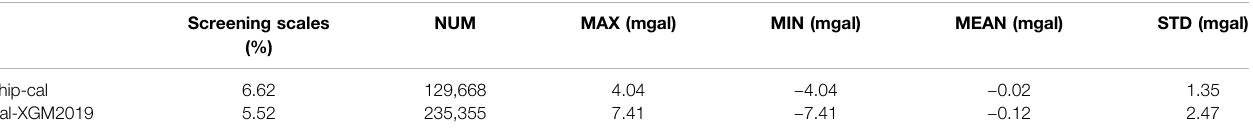
TABLE 10 | Statistical information of compared with shipborne data and XGM2019 gravity fi eld